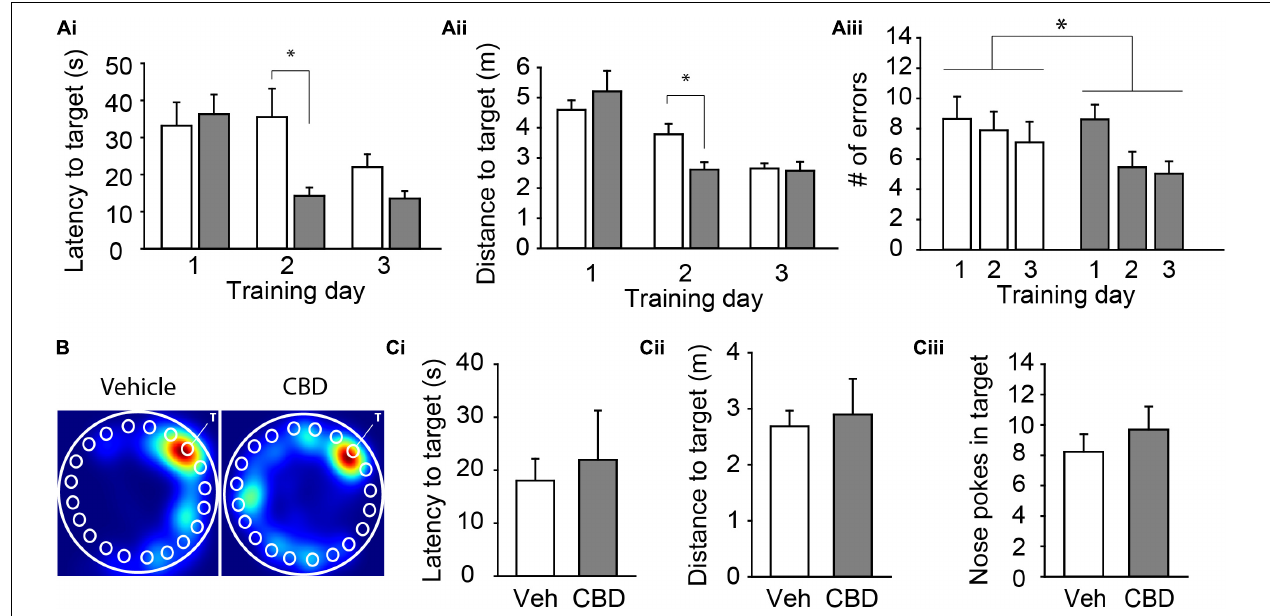
FIGURE 3 | Adolescent CBD exposure improves the rate of learning of a spatial memory task. Summary bar charts showing the mean latency (Ai) and mean distance traveled (Aii) to the escape box as well as the mean number of errors (Aiii) on each day of acquisition. CBD-treated mice had shorter latency to target (14.29 ± 4.85 s) and distance to target (2.61 ± 0.38 m) on day 2 compared to vehicle treated mice (38.09 ± 5.05 s; 3.78 ± 0.39 m). CBD treated mice made fewer errors across all acquisition days (6.37 ± 0.59 errors) than vehicle-treated mice (7.88 ± 0.77 errors). (B) Representative heat maps in the Barnes maze on the probe day of subjects administered vehicle (left) and CBD (right). The white “T” indicates target hole. Summary bar charts showing that there was no difference in the latency to the target hole (Ci) , distance to the target hole (Cii) , or number of nose pokes into the target hole (Ciii) on the probe day between the vehicle (18.04 ± 4.12 s; 2.69 ± 0.28 m; 8.23 ± 1.16 nose pokes) and CBD (21.93 ± 0.93 s; 2.90 ± 0.64 m; 9.69 ± 1.52 nose pokes) treated groups. ∗ indicates P < 0.05 by Tukey’s HSD post hoc